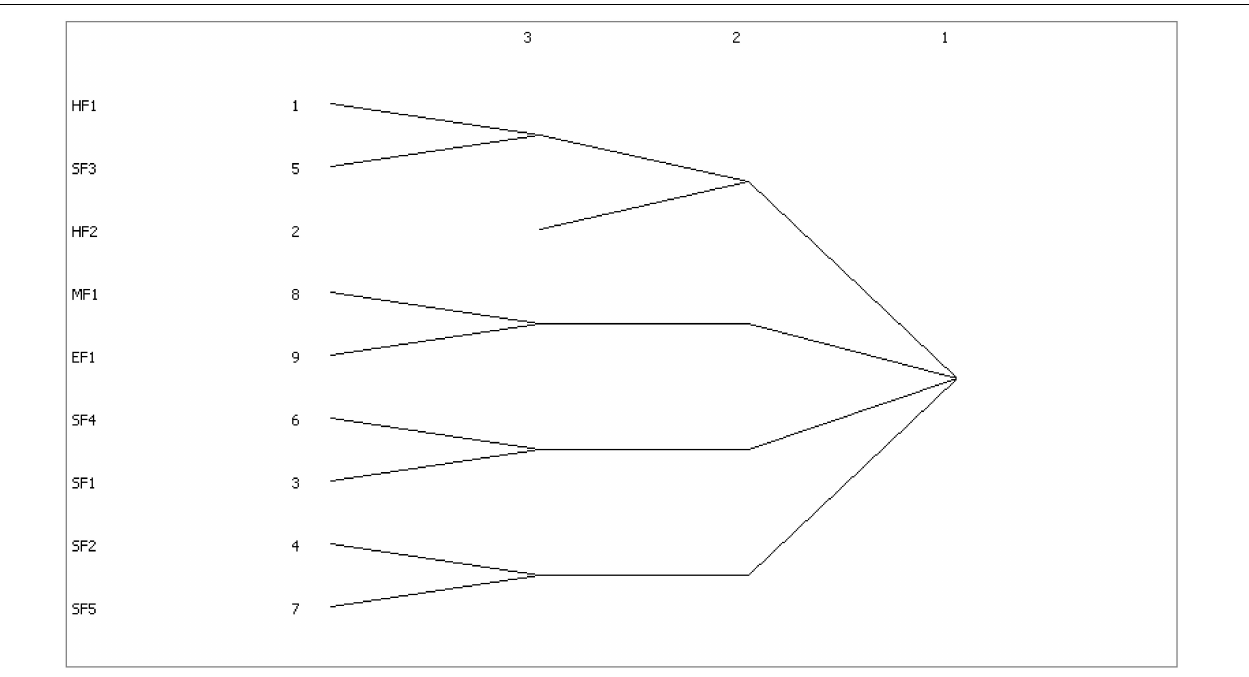
FIGURE 5 | Network aggregation subgroup tree of influencing factors of construction workers’ unsafe